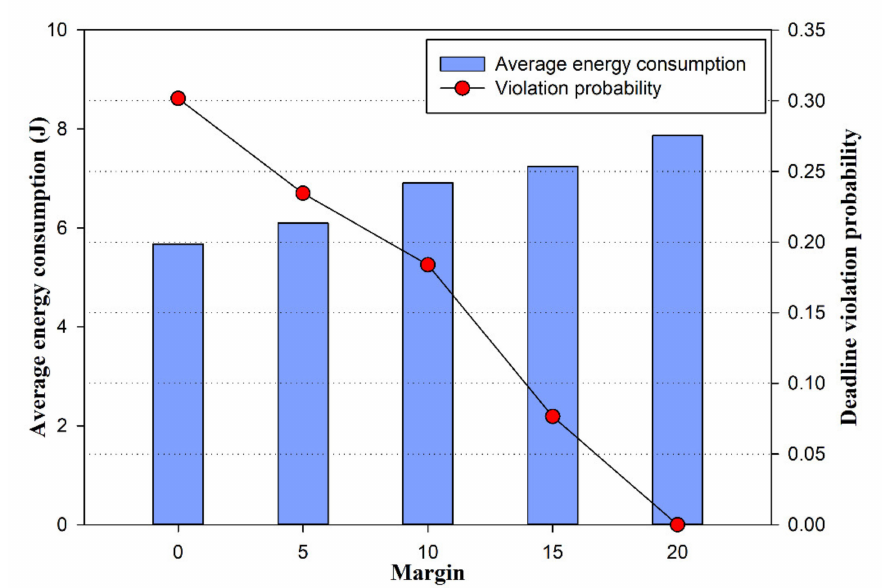
Figure 10. Tradeo ff s between average energy consumption and deadline violation